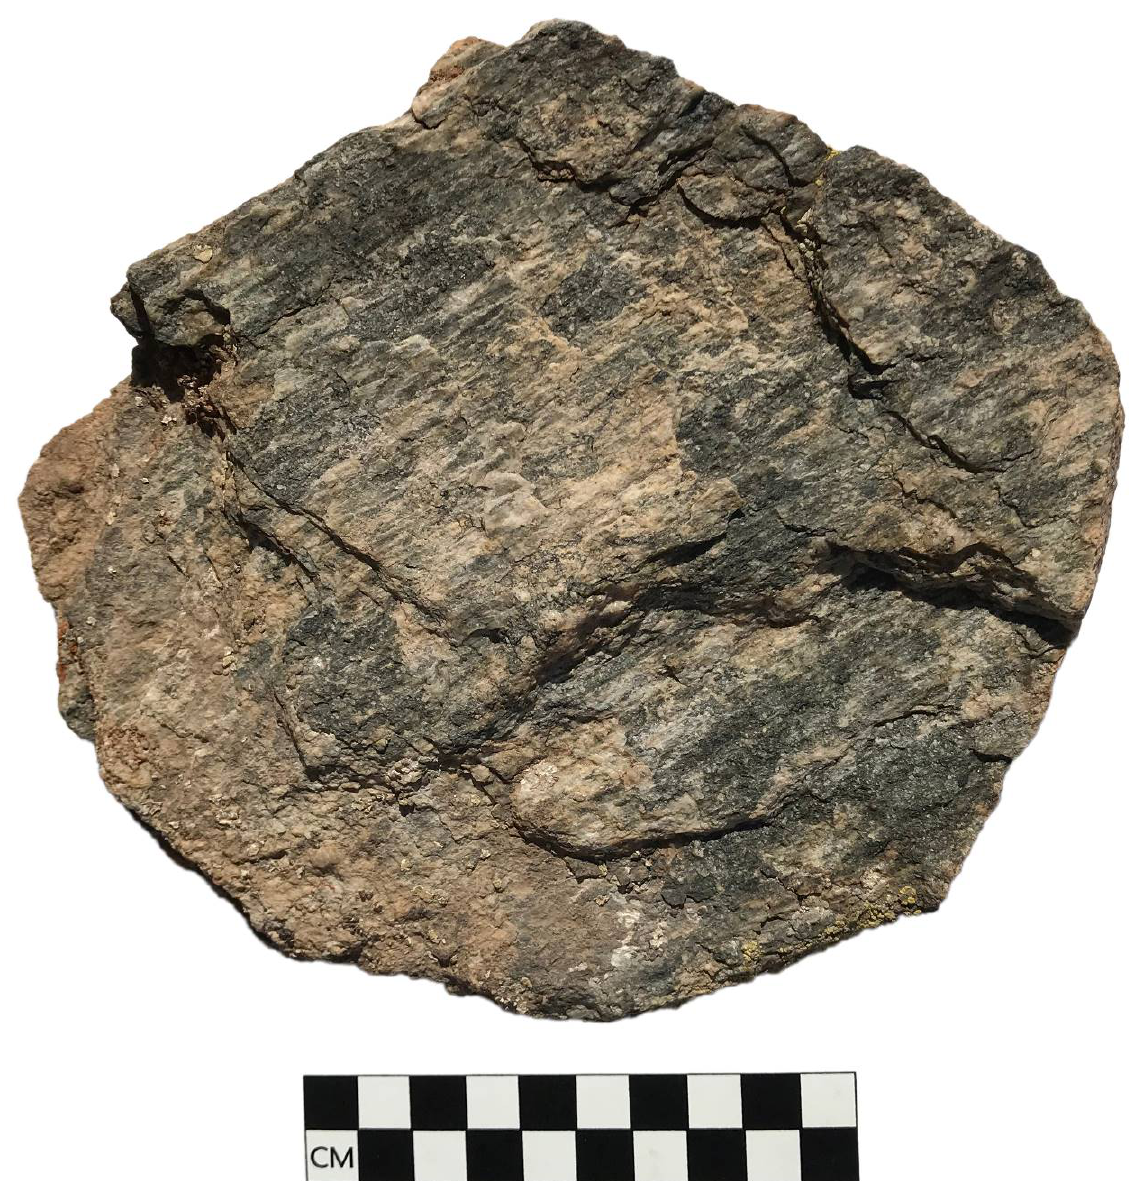
Figure 3. A disc-shaped tool (Specimen 19) of schist from the surface of site AZ CC:1:2 (ASM) (Doolittle & Neely 2004). Working edge facing downward (see Figure 1). (Photograph by James